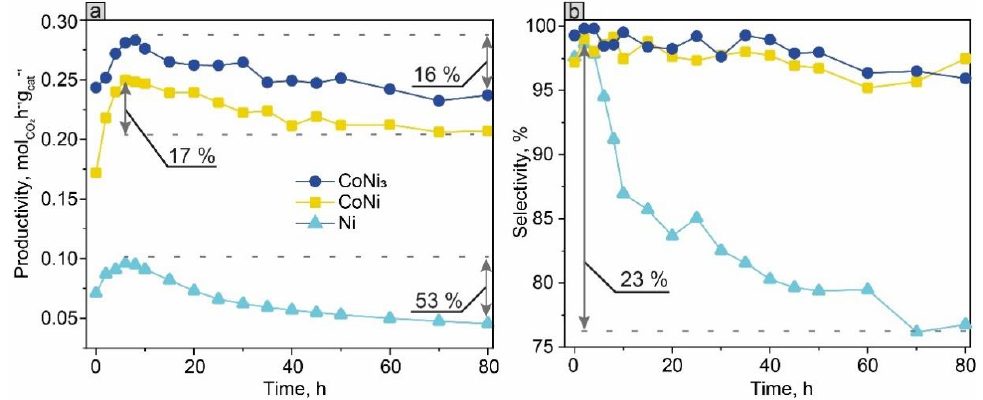
Figure 6. Productivity ( a ) and CH 4 selectivity ( b ) for the CoNi, CoNi 3 , and Ni catalysts, during the ◦ 80-hour-long CO 2 hydrogenation reaction at 300 °C . 80-h-long CO 2 hydrogenation reaction at 300